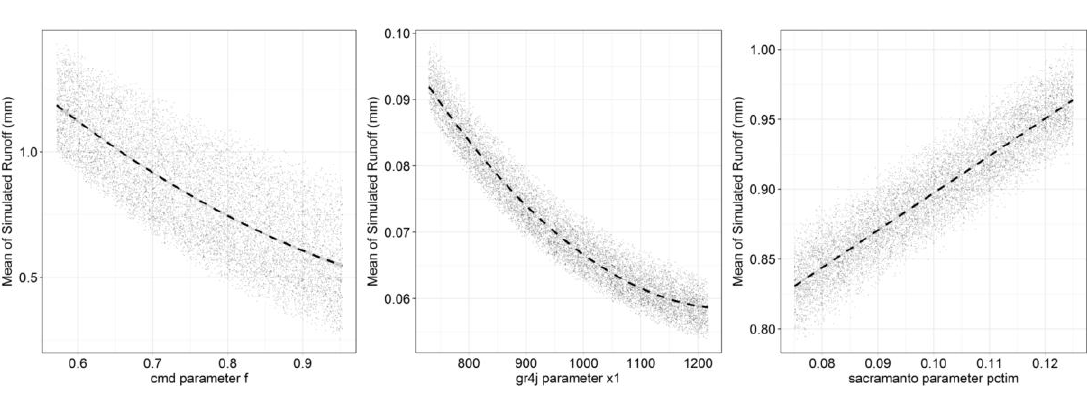
Figure 3. Sensitivity of simulated runoff from 10,000 parameter sets for three RR models and their most sensitive model parameter.